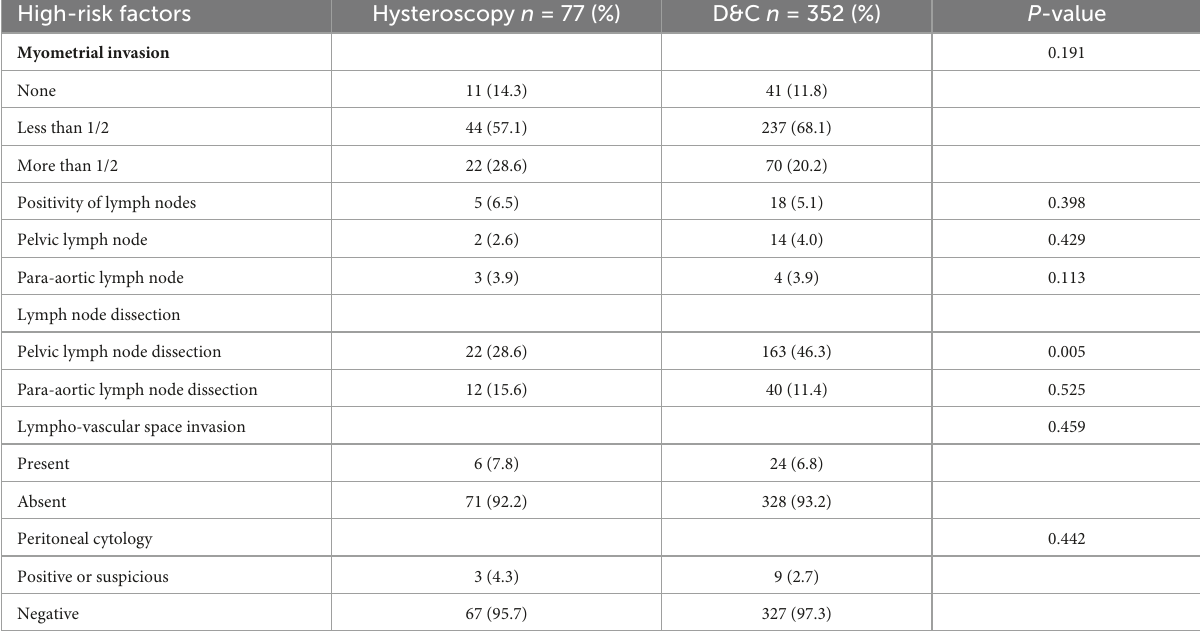
TABLE 2 Comparing pathological conditions that may affect the prognosis of EC between HSC and D&C. High-risk